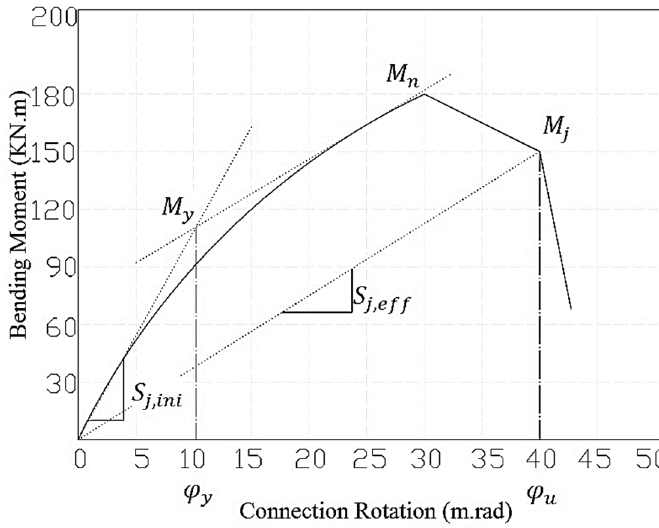
Figure 16. Typical moment-rotation response.